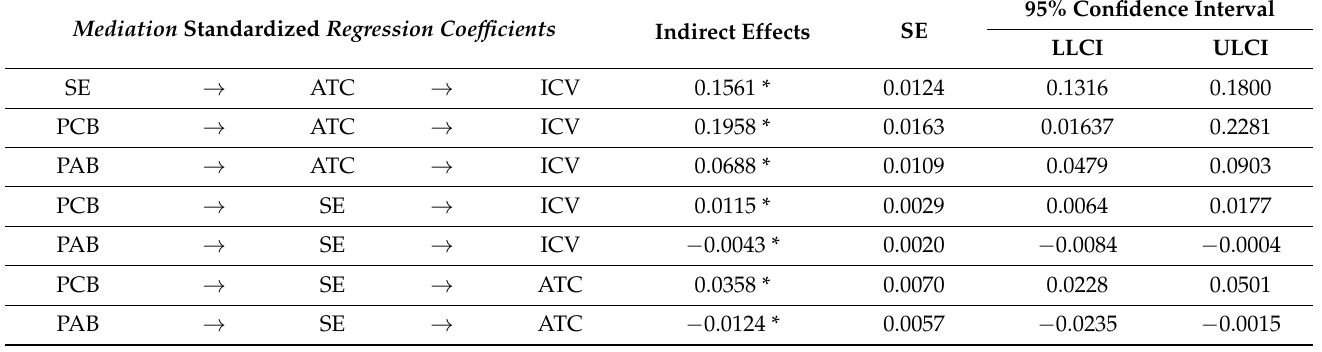
Table 5. The mediation